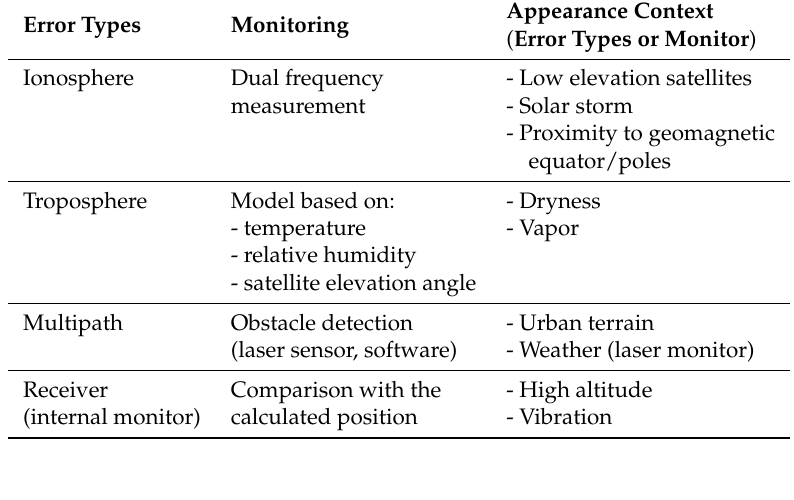
Table 5. FMEA for GPS.